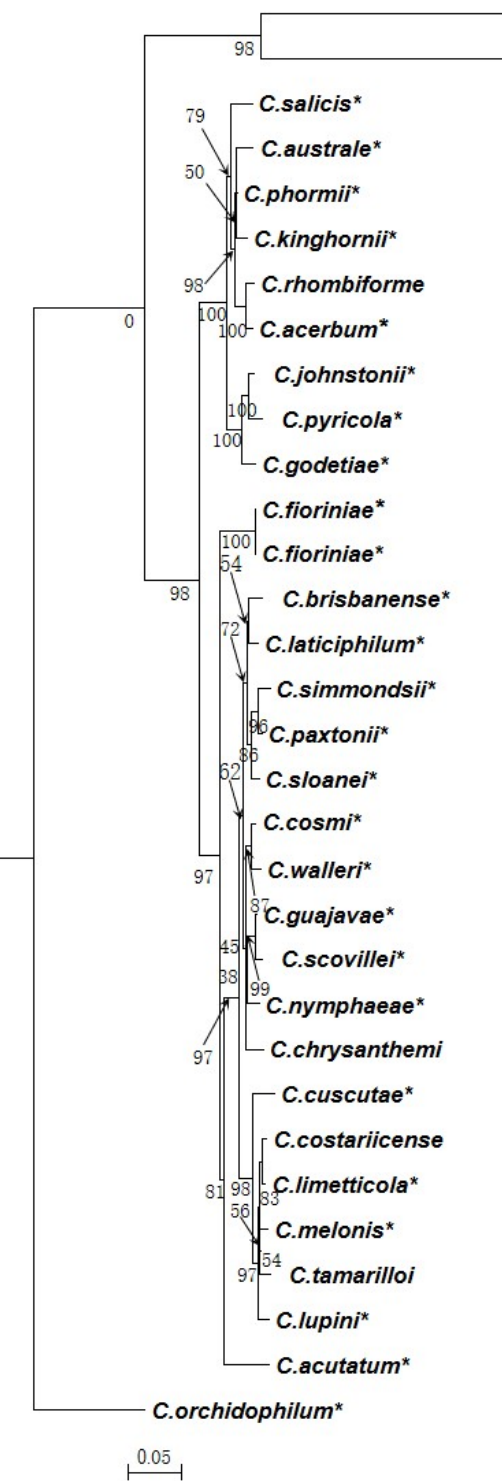
Figure 2. A Bayesian inference phylogenetic tree of the C. acutatum species complex. The tree was constructed with a Bayesian analysis of concatenated internal transcribed spacer (ITS), partial beta tubulin 2 ( TUB2 ), acting ( ACT ), chitin synthase ( CHS-I ), and glyceraldehyde-3-phosphate dehydroge- nase ( GAPDH ). The Markov chain was run for 5,000,000 generations, each locus having a separate model of DNA evaluation. C. orchidophilum (CBS 632.80) was used as an outgroup. The scale bar shows 0.05 expected changes per site. * The reference